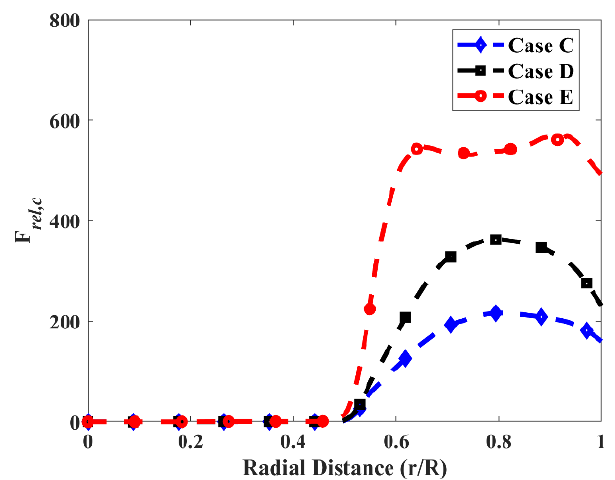
Figure 10. Comparison of average relative centrifugal forces along the chamber radius for cases C–E in the presence of droplets/particles at z/Z = 0.5. Here, r/R = 0 represents the centerline of VC (where spray nozzle is located), and r/R = 1 represents the wall of VC.